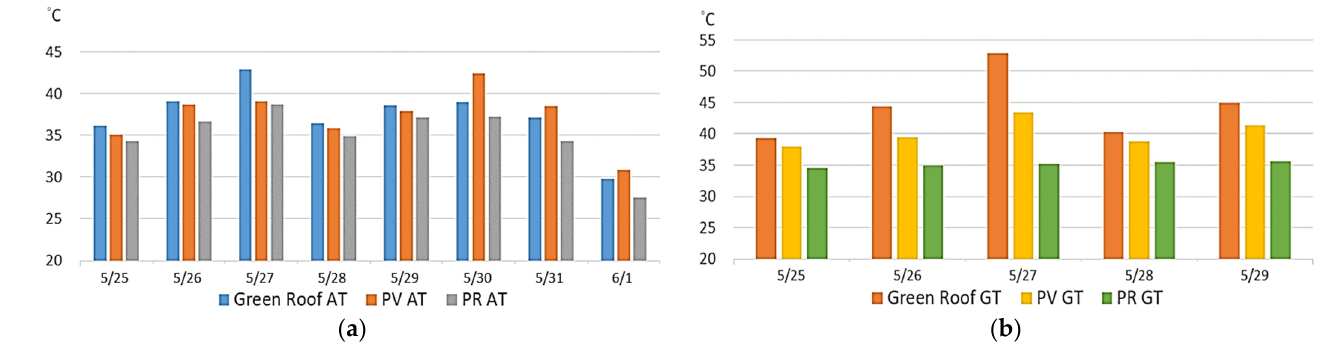
Figure 12. Comparison of overall environments: ( a ) air temperature ( b ) ground temperature.